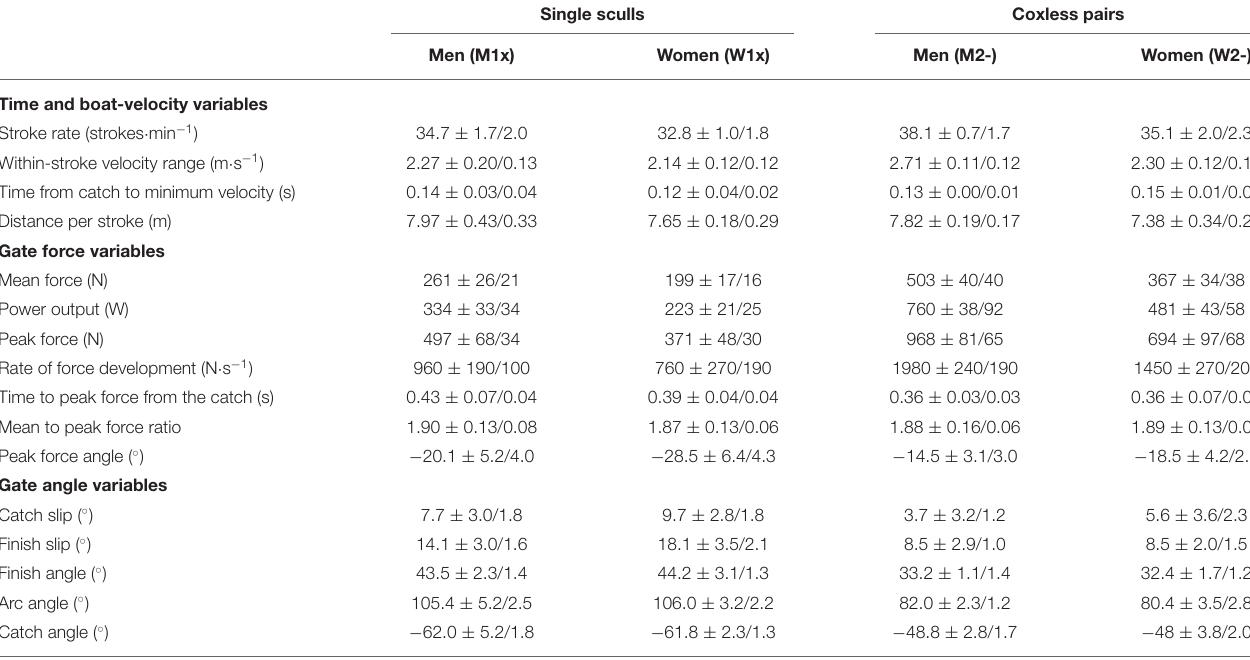
TABLE 1 | Characteristics of the predictor variables in the four boat classes. Data are mean ± between-crew SD/within-crew SD a